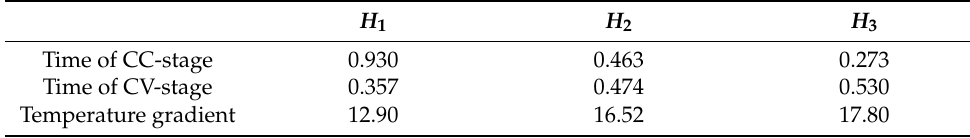
Table 4. Indicator assessment levels and reference value.